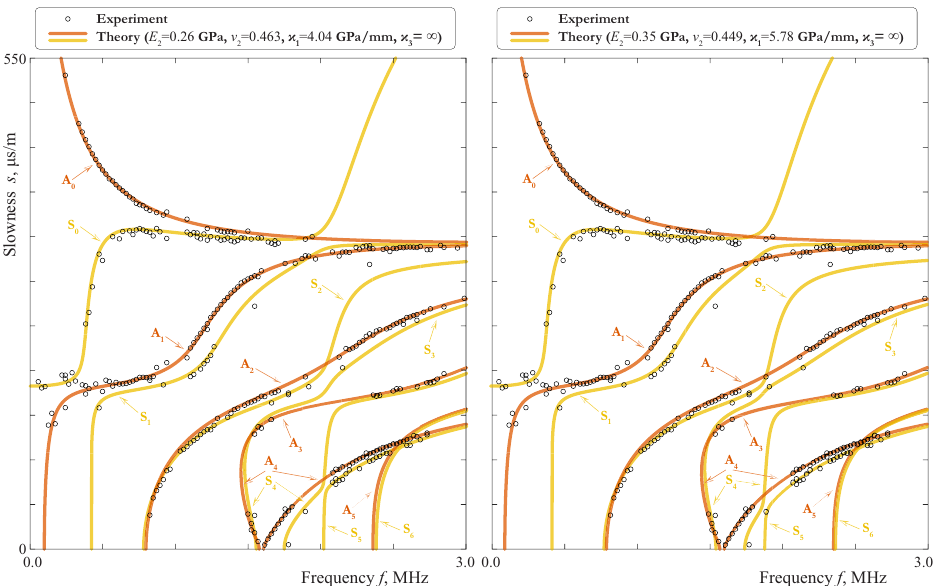
Figure 18. Slownesses of LWs propagating in 4.05 mm thickness plate (2 mm aluminium/50 µ m film/2 mm aluminium) determined via the MPM (circles) and estimated theoretically (solid lines). Table 2. Material properties found